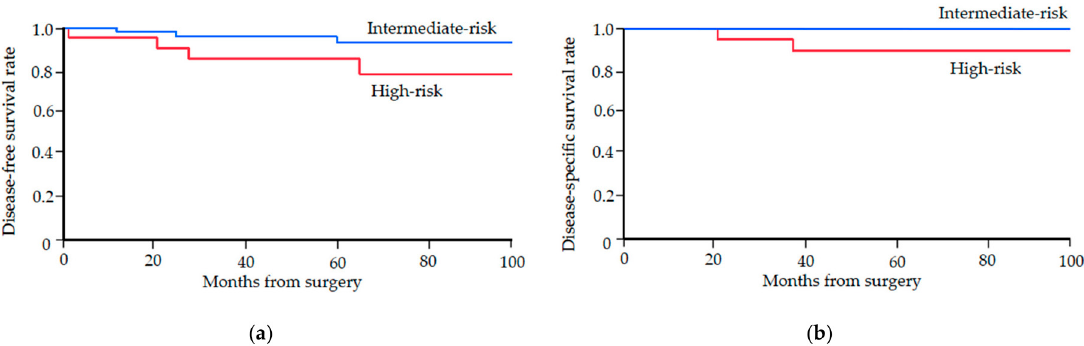
Figure 1. Kaplan-Meier survival curves for uterine-confined intermediate- and high-risk groups. ( a ) Disease-free survival. ( b ) Disease-specific